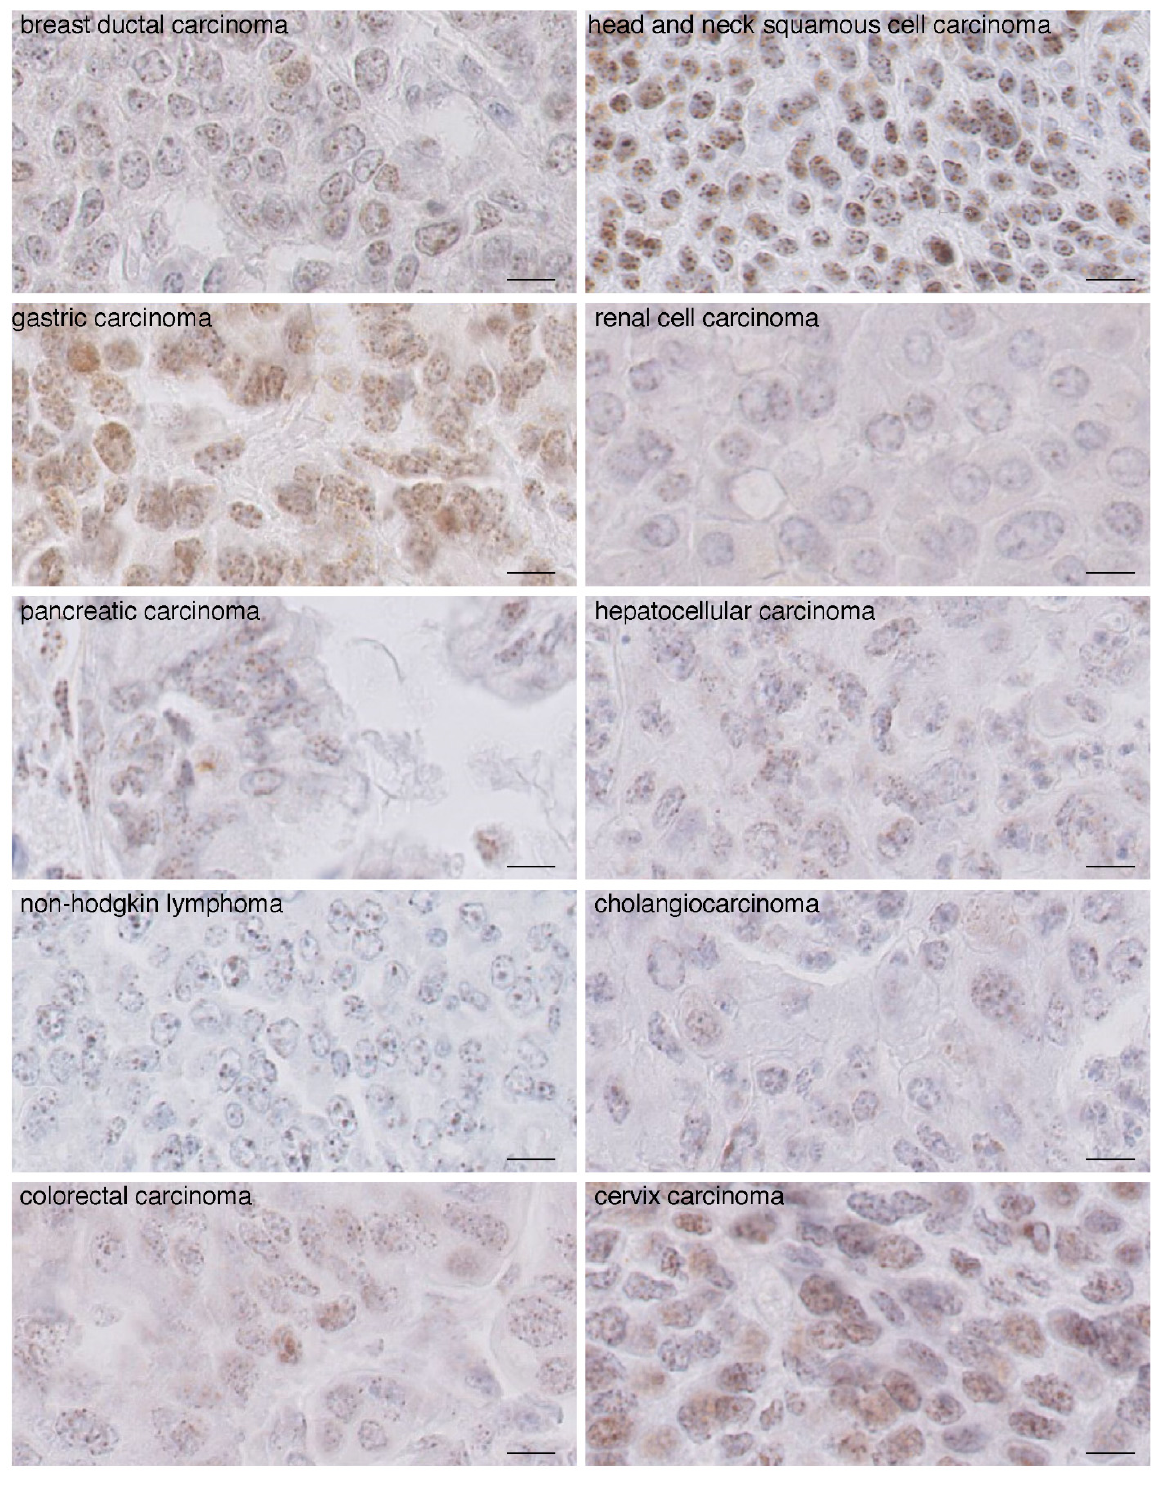
Figure 2. CENP-A staining by IHC in carcinomas reveals a pattern distinct from that of non-tumoral tissue. Images of CENP-A staining by IHC in non-Hodgkin lymphoma and carcinomas as indicated. Scale bar is 10 µm.